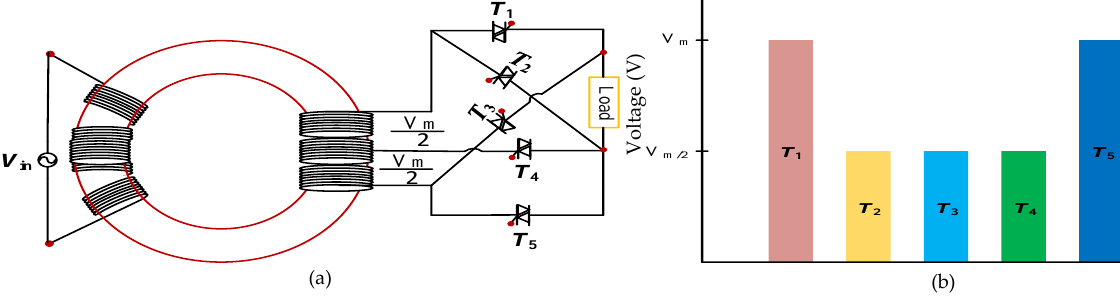
Figure 3. ( a ) Proposed cycloconverter topology (1/3) and (1/4) frequency conversion of 50 Hz; ( b ) voltage stress of individual switches of proposed cycloconverter.